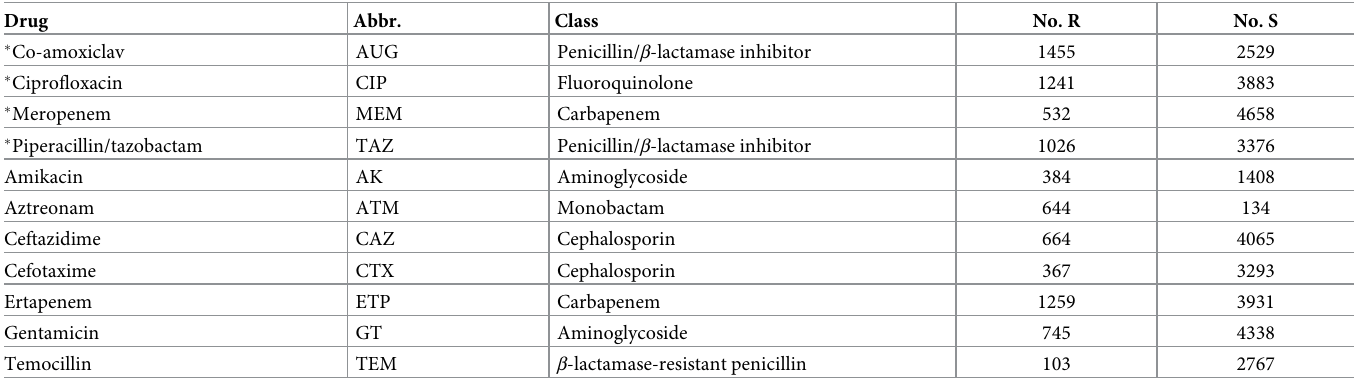
Table 1. List of antimicrobial agents considered in the study. For each of these antibiotics and each admission event, binary variables record whether the antibiotic: a) was currently prescribed, b) has been prescribed to the same patient in a previous admission, c) resistant isolate was detected, d) susceptible isolate was detected, e) was pre- scribed within 72 hrs of admission (early prescription); other variables record f) the number of times resistant isolates were detected in previous admissions, d) the number of times susceptible isolates were detected in previous admissions. The 4th and 5th columns report the number of admissions which had resistance tested and outcome pos- itive (R) and negative (S), respectively. Resistance during the current admission to the four drugs marked with a star (AUG, CIP, MEM, and TAZ) are outcomes set to be predicted by four different AI classifiers.